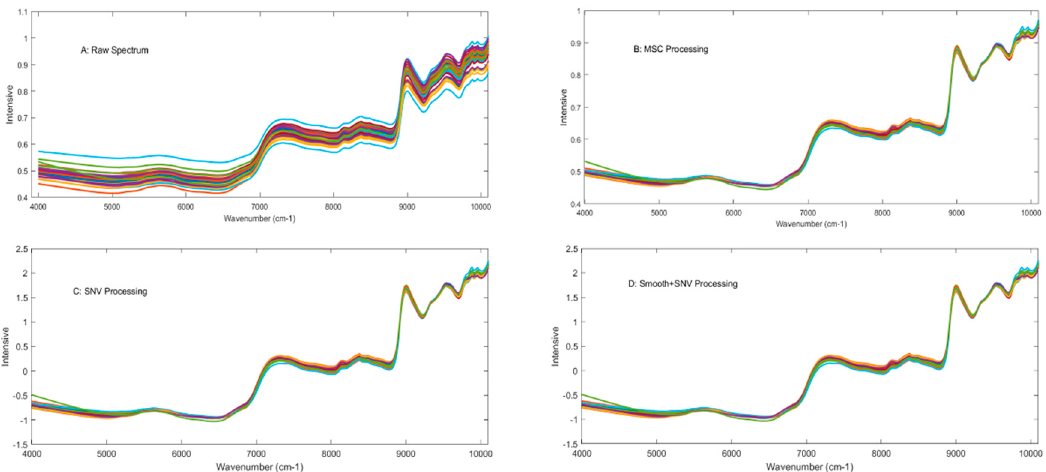
Figure 1. Raw NIR spectra of all samples ( A ) and processed with MSC, SNV, and “Smooth+SNV “methods, respectively ( B , C , and D ).